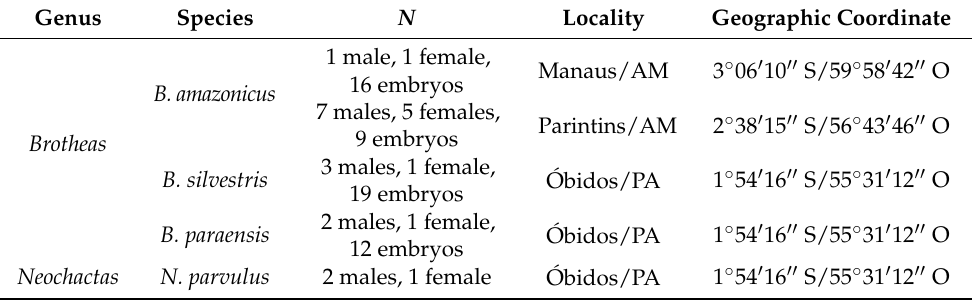
Table 1. General data about the sample used in this